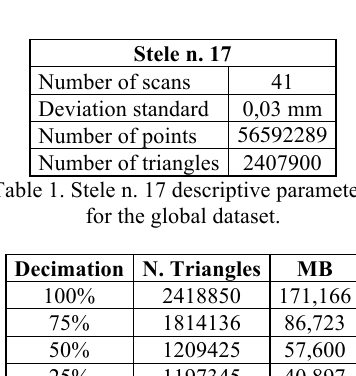
Figure 2. Stele n.17: high density point cloud (on the left) and 3D high resolution mesh (on the right).